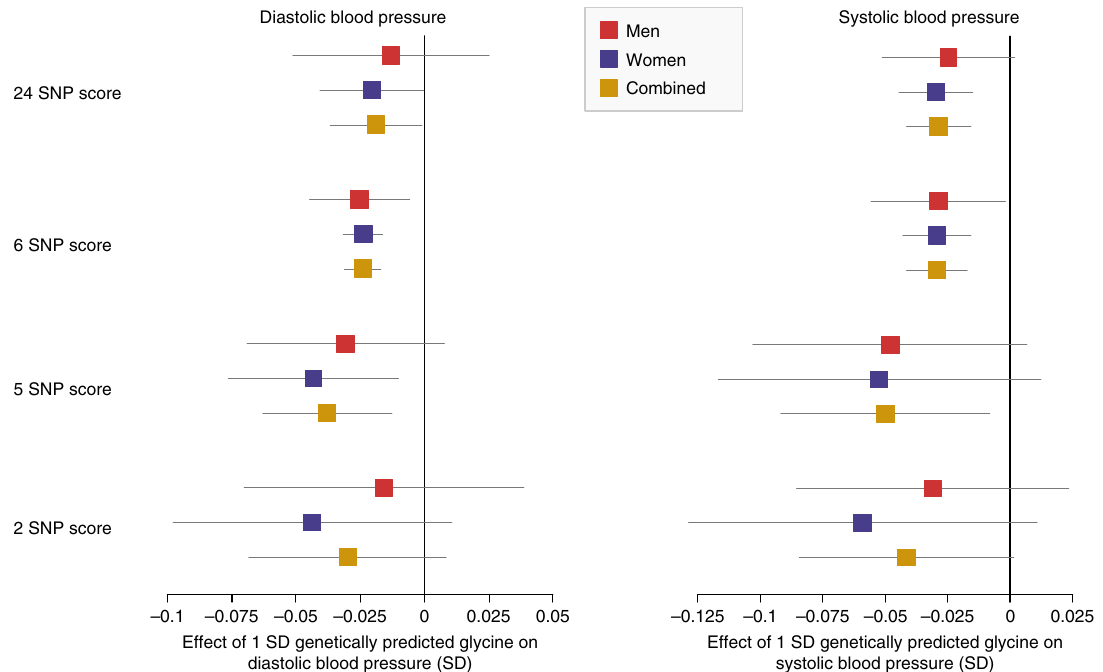
Fig. 6 Genetically predicted effect size ± 95% con fi dence intervals of glycine on diastolic and systolic blood pressure, in sex-combined and sex-speci fi c analyses, using four different genetic scores for glycine. Associations are based on 203,943 male and 241,417 female European ancestry UK biobank participants